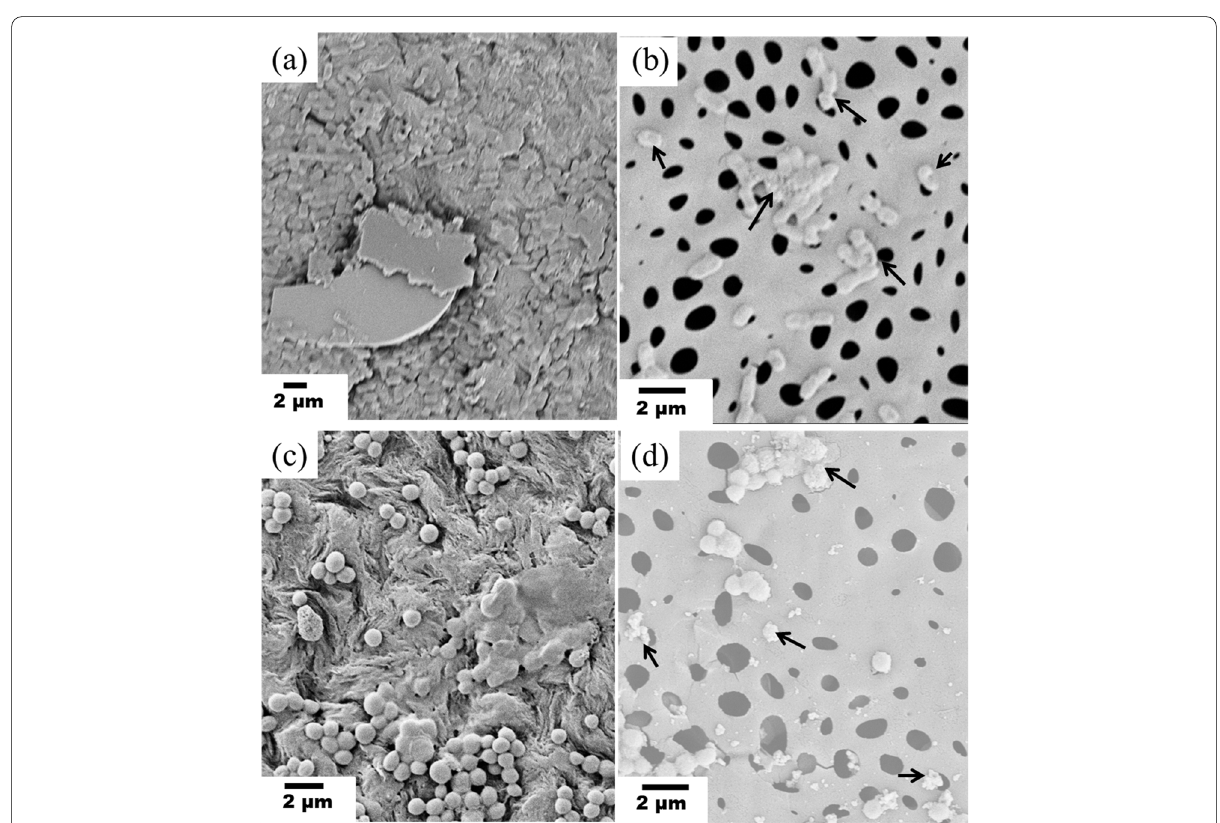
Fig. 12 SEM image of control membrane ( a , c ) and PSS-PDA- crosslinked GO membrane ( b , d ) on incubation for 2 h with E. coli and S. aureus respectively. The arrow marks show destruction of